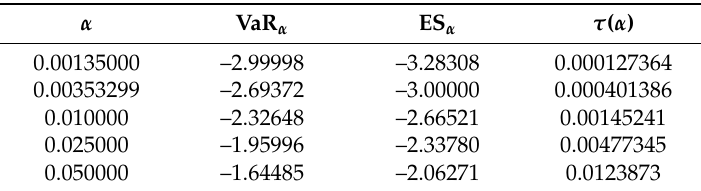
Table 3. Normally distributed VaR, expected shortfall, and τ for different values of α . α VaR α ES α τ ( α